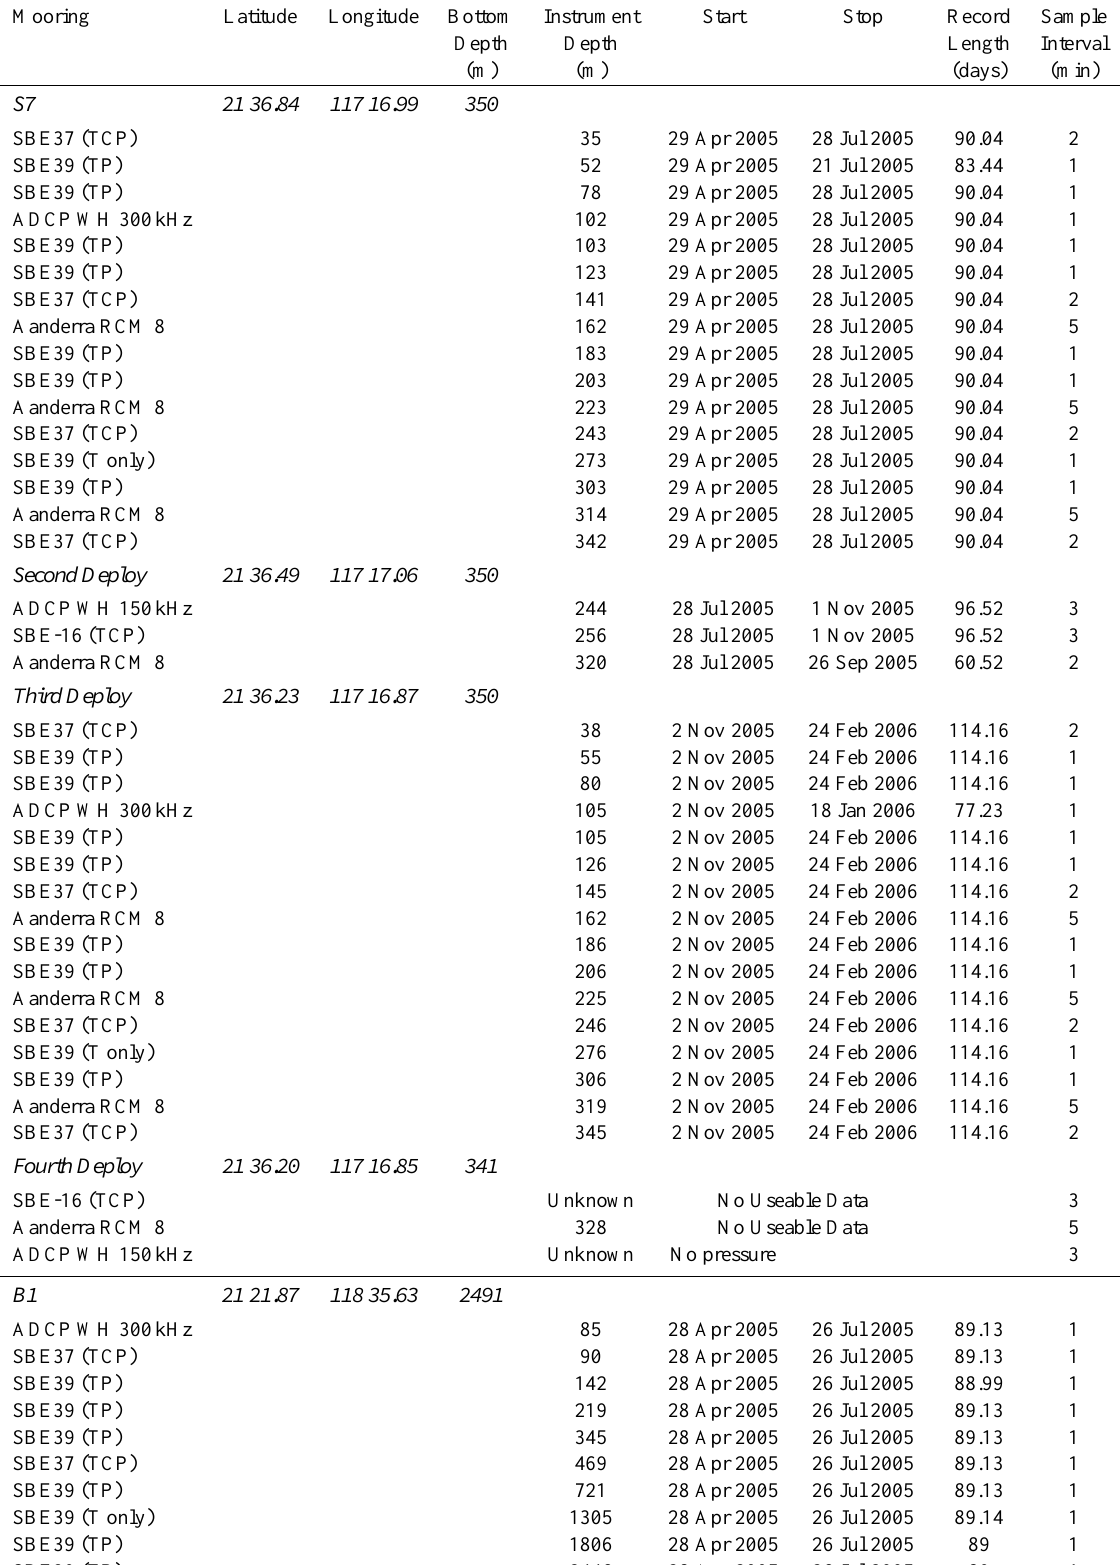
Table 1. Mooring and instrument locations for the four deployments in the South China Sea. Mooring Latitude Longitude Bottom Instrument Record Sample Depth Depth Length